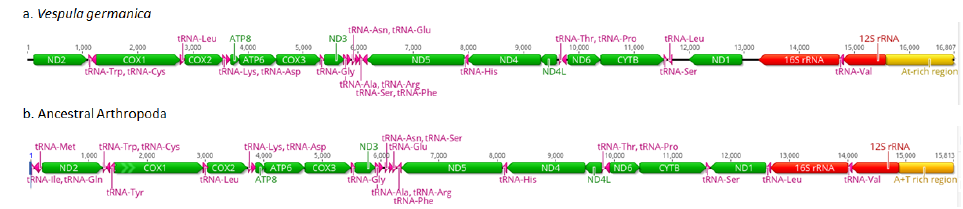
Figure 3. ( a ) Gene order and content of the partial mitochondrial genome of Vespula germanica and